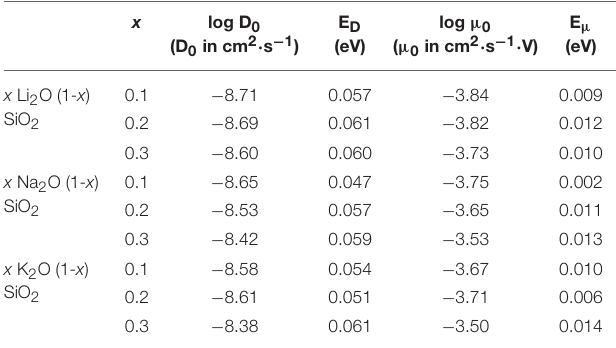
TABLE 4 | Intercept (log D 0 , D 0 in cm 2 · s − 1 and log µ 0 , µ 0 in cm 2 · s − 1 · V) and activation energy (E D and E µ , both in eV) for the diffusion process and the ionic mobility, respectively, calculated using the Arrhenius equation and the data from Figure 2